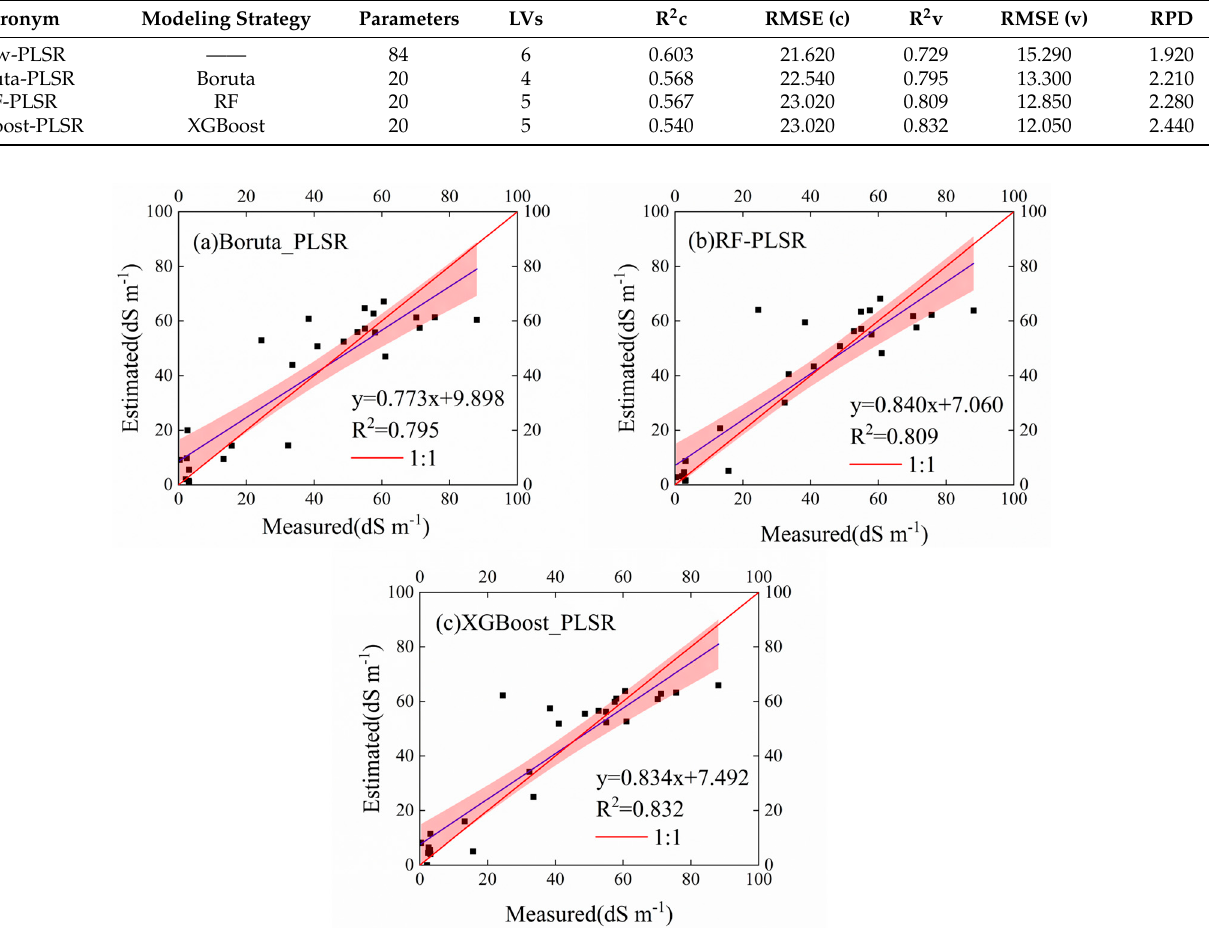
Figure 8. Scatter plots of the measured versus estimated electrical conductivity (EC) using different models with various modeling strategies: ( a ) random forest partial least-squares regression (RF- PLSR), ( b ) Boruta-PLSR, ( c ) extreme gradient boosting